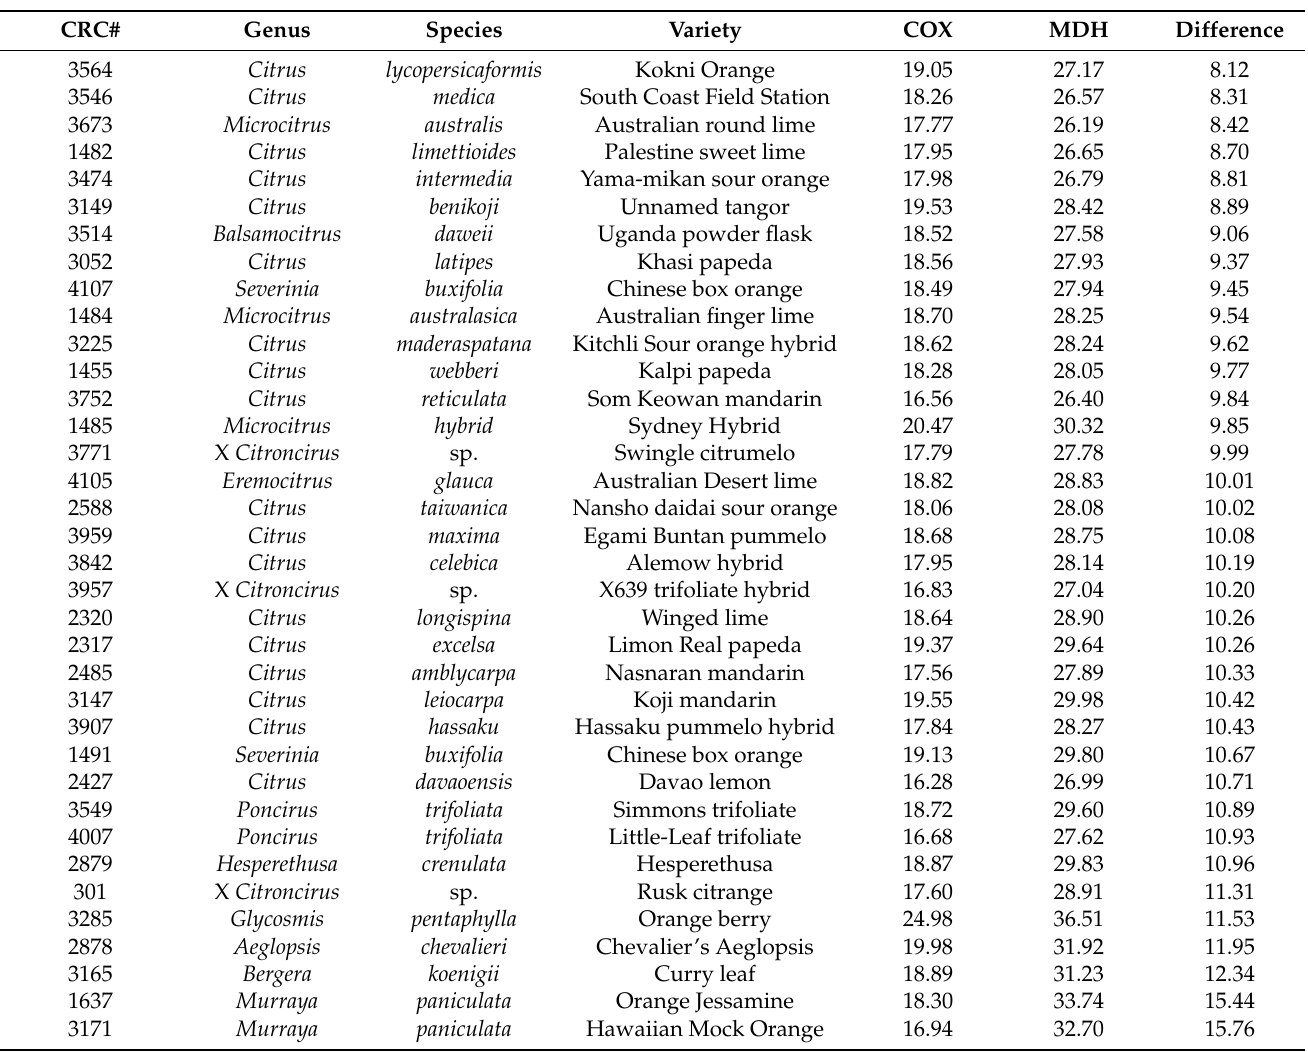
Table 2. Evaluation of two reference genes, COX and MDH, in duplex qPCR assays. Two duplex qPCR assays for detecting 16S rDNA of CLas were conducted, one using variable multicopy mitochondrial COX gene and another using nuclear single copy MDH gene. The plant samples were collected from a field in HLB endemic area in Florida [28], DNA extractions were made and used for assays. The cycle threshold (Ct) values for only the reference genes are shown. In specific citrus relative genera, a Ct difference of up to 15 was observed between the two reference genes. The CRC numbers refer to the citrus research center IDs for the seed source trees from the Citrus Variety Collection, University of California